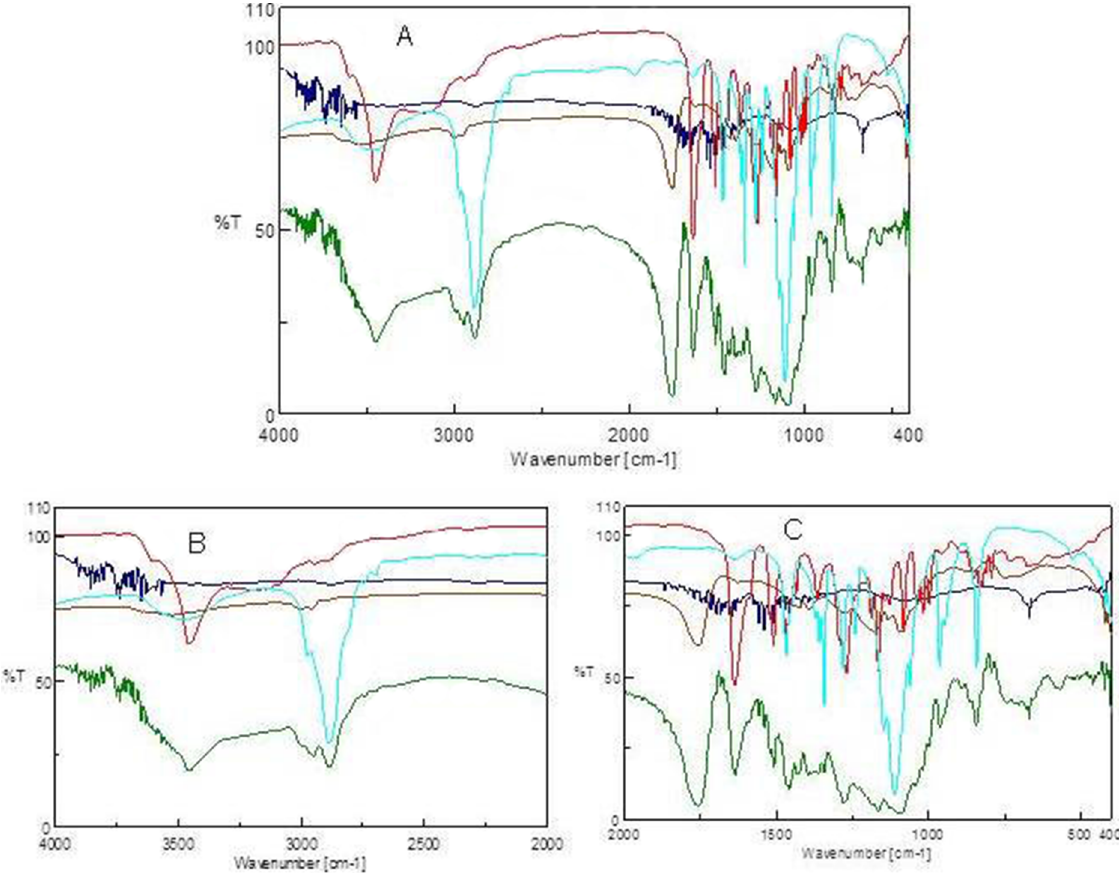
Figure 2. FTIR scans for silybin, PLGA, chitosan, pluoronic and CSbnp. A) FTIR scan over the mid IR region (cm 2 1 ), B) comparison zone upfield, C) comparison zone down field. [Colour codes silybin (red); PLGA (brown); chitosan (blue); pluoronic (sea green); CSbnp (green)].